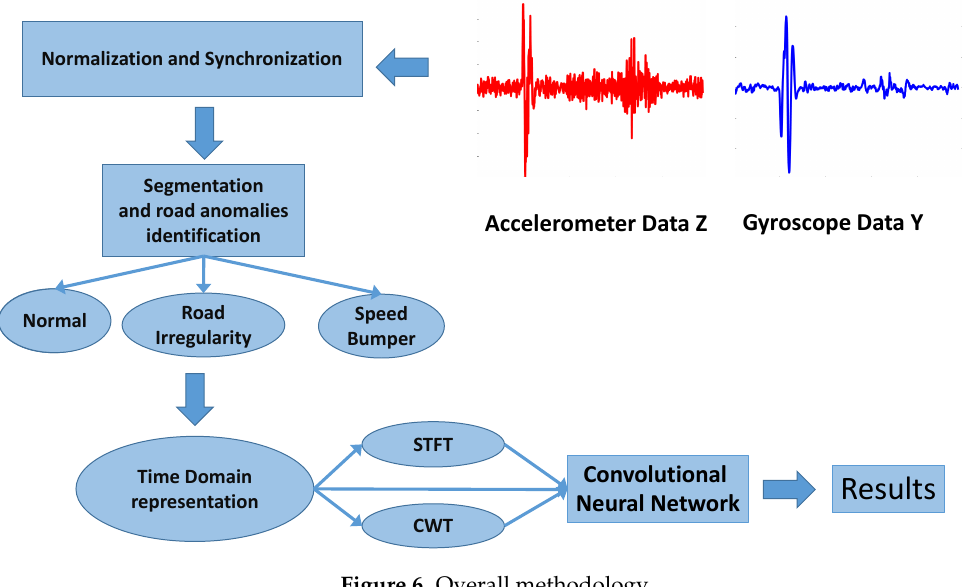
Figure 6. Overall methodology.